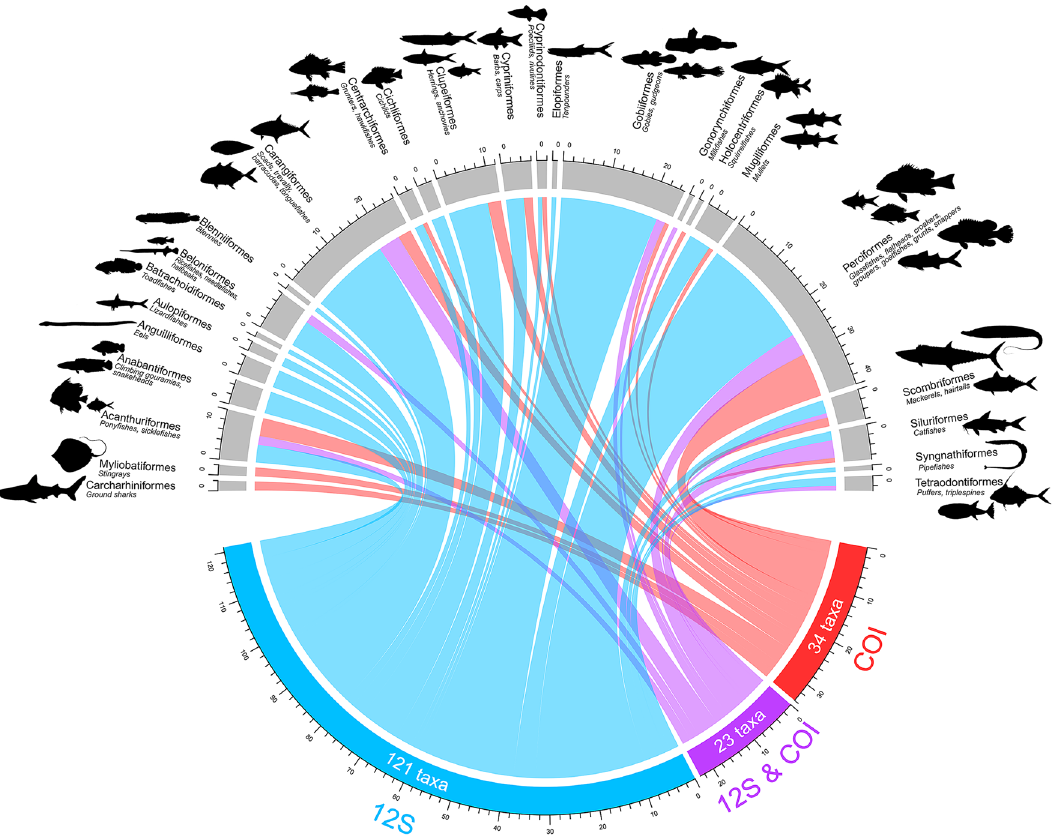
Figure 2. Actinopterygian and elasmobranch taxa detected from eDNA by the COI and 12S metabarcoding assays. Circlize plot showing assays being mapped to the 25 orders detected by eDNA metabarcoding. The purple ribbons represent overlapped detections from both COI and 12S metabarcoding